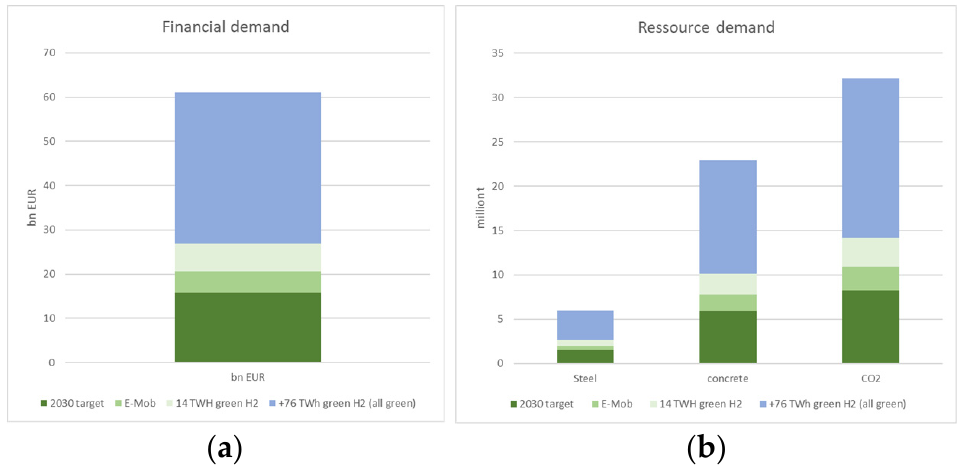
Figure 1. Financial and resource demand when using turbines of Type 1.